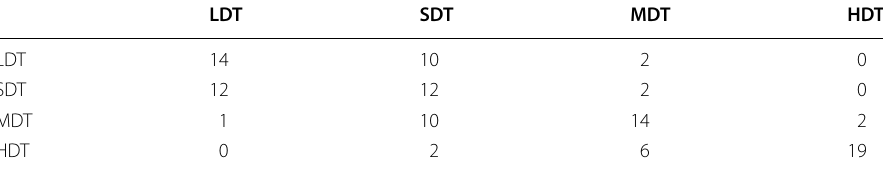
Table 10 Confusion matrix for the Decision Tree